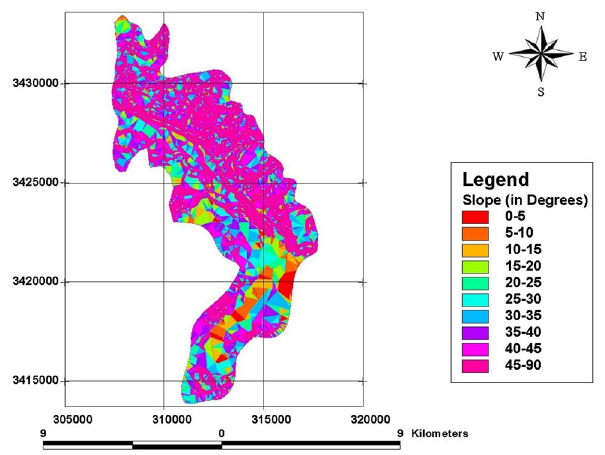
Fig. 8 Slope map (in degrees) of the Gangotri glacier area